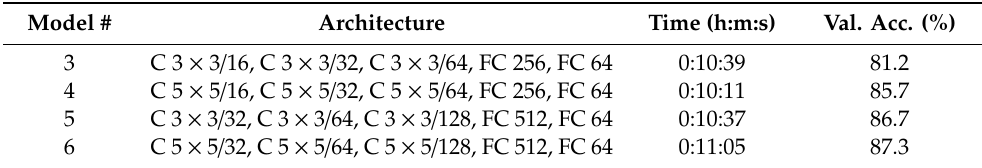
Table 4. Experimental results of Models 3–6 using data augmentation operations. The convolutional layers’ parameters are denoted as “C kernel size / number of kernels”. The fully connected layers are denoted as “FC number of hidden units”. Epoch = 30 and learning rate = 1 × 10 − 4